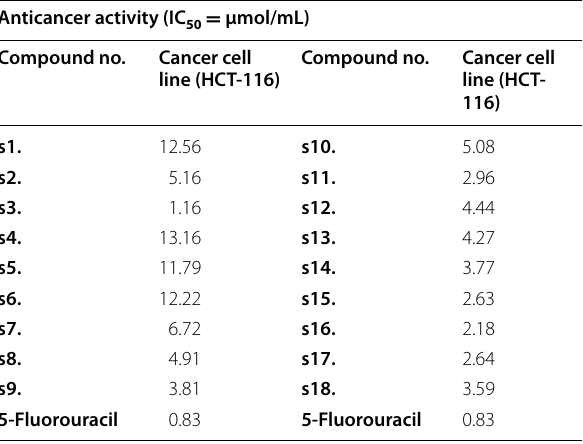
HCT-116 human colorectal carcinoma